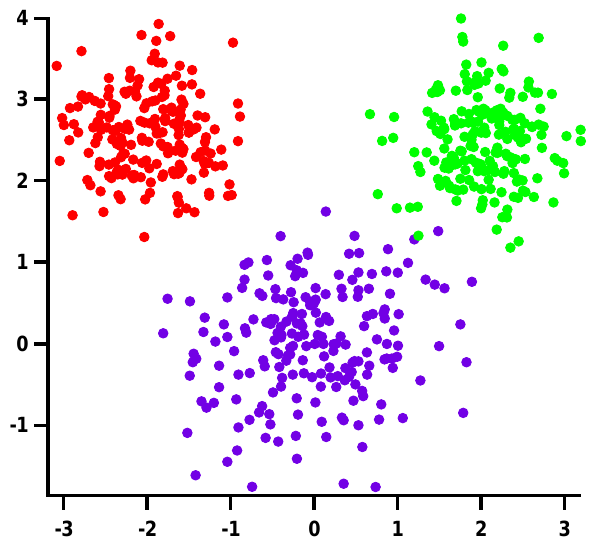
Fig. 1. Input to cluster analysis routine. Three synthetic, separately generated groups (differentiated by colour) of random, normally distributed data of arbitrary units centred around three separate points.